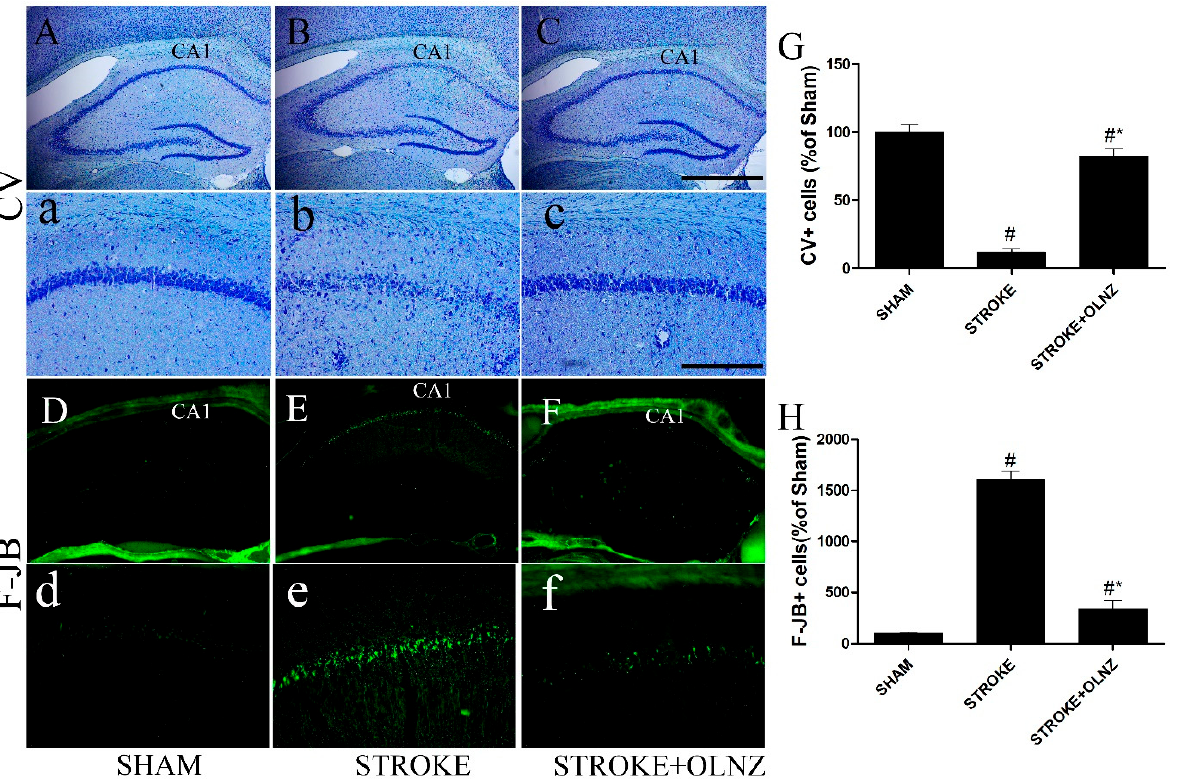
Figure 2. Role of OLNZ in CV positive neuronal cells and F-J B histofluorescence neuronal cells in the hippocampus of CA1 domain. Identification of CV positive cells in the sham group ( A ) 10 × and ( a ) 200 × , TI-mediated ischemic stroke group ( B ) 10 × and ( b ) 200x, and TI-mediated ischemic stroke + OLNZ (10 mg/kg) group ( C ) 10 × and ( c ) 200x. F-J B histofluorescent of the CA1 domain in the sham group ( D ) 10 × and ( d ) 200 × , TI-mediated ischemic stroke group ( E ) 10 × and ( e ) 200 × , and TI-mediated ischemic stroke + OLNZ (10 mg/kg) group ( F ) 10 × and ( f ) 200x. In the TI-mediated stroke gerbils, the number of CV positive cells in the CA1 domain was reduced compared with the sham group, although a greater number of F-J B+ degenerative cells were distinguished in the hippocampus of the ischemic group compared to both the sham and TI-induced stroke + OLNZ treatment groups. ( G ) Graphs represent the relative numbers of CV+ and ( H ) F-J B+ cells. Data were expressed as the mean ± SEM, n = 5 in each group. After performing one-way ANOVA with Tukey’s post hoc tests, p < 0.05 for comparisons of the treatment groups with the sham group (#) and p < 0.05 for comparisons with the TI-induced stroke group (*) were considered